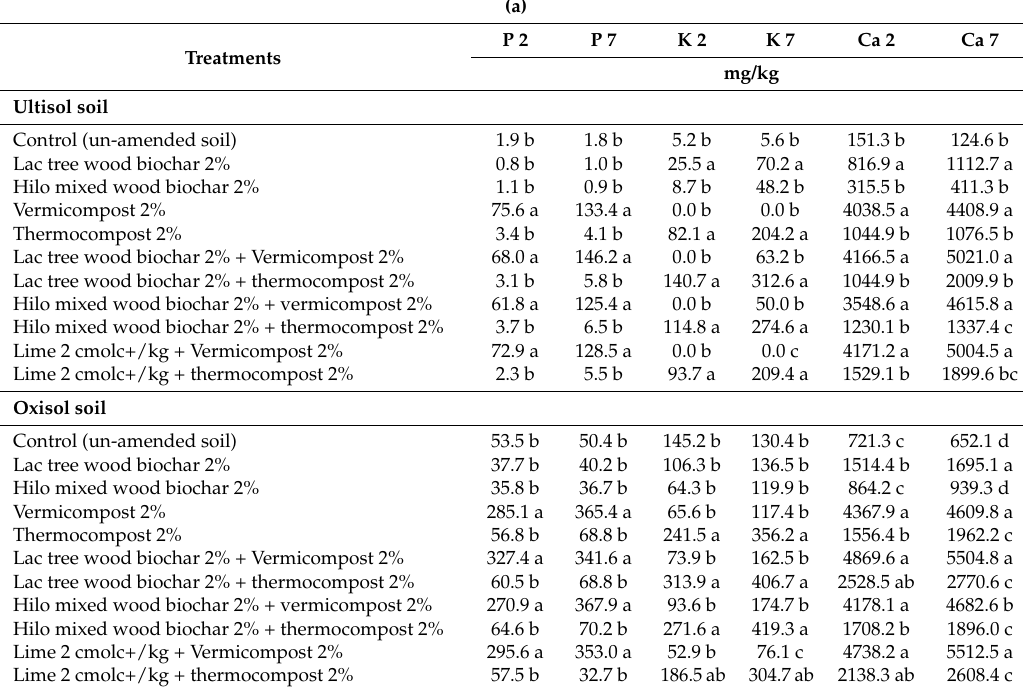
Table 4. (a). Means and standard errors of Mehlich-3 extractable P, K and Ca in the soils as affected by the additions of biochars, lime, and/or composts ( n = 3). (b). Means and standard errors of Mehlich-3 extractable Mg, Fe and Mn in the Hawaiian soils as affected by the additions of biochars, lime, and/or composts ( n =